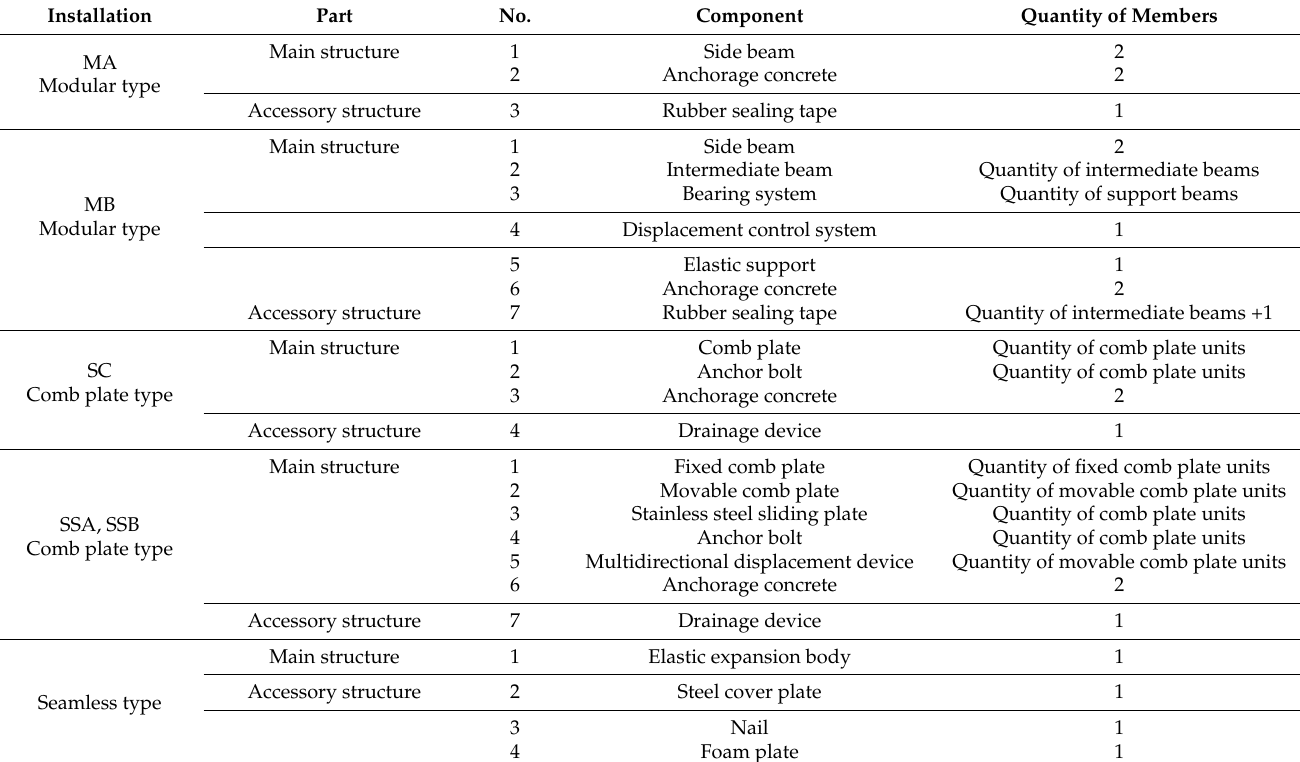
Figure 2. Framework of BECI technical condition assessment. Table 1. Hierarchical classification of